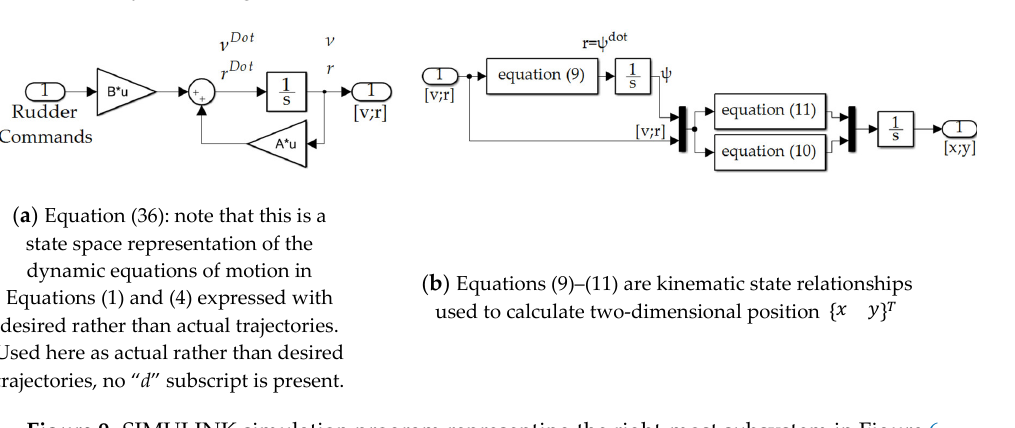
Figure 8. Optimal learning topology manifest as a SIMULINK simulation program representing the lower left subsystem in Figure 6.